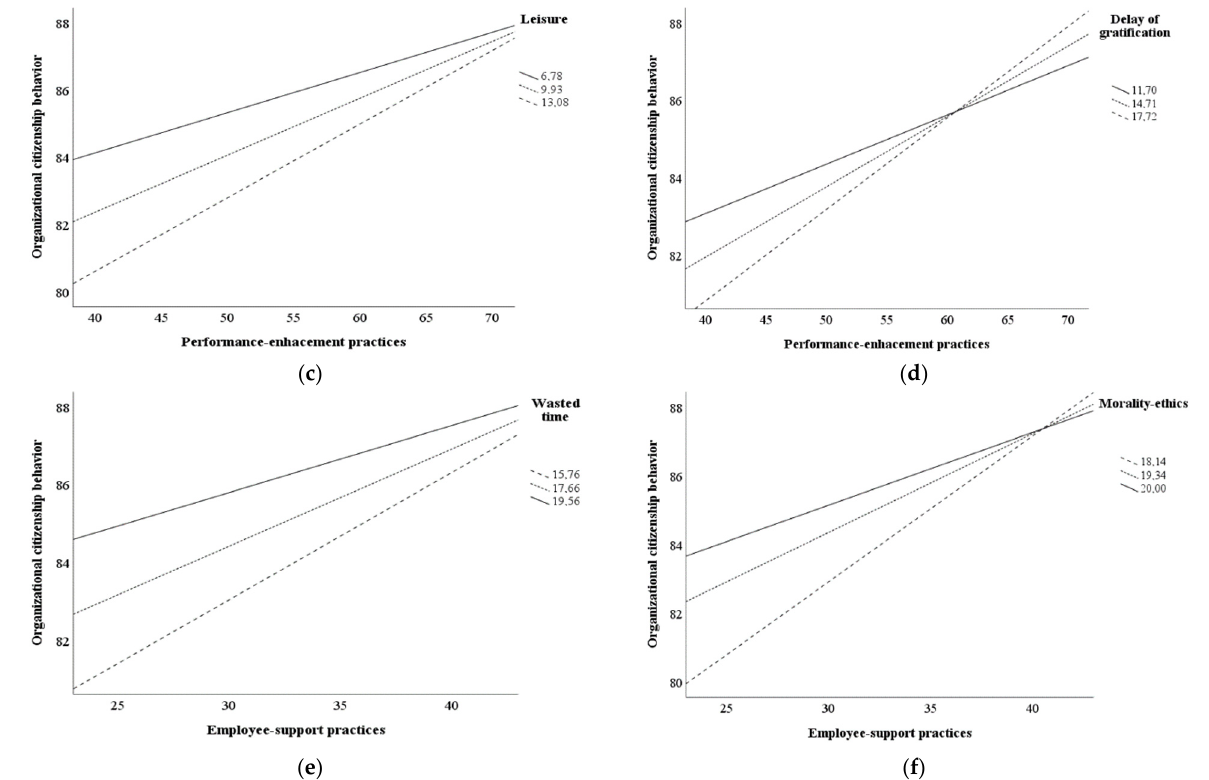
Figure 2. HRP-PWE moderations to predict Organizational Citizenship Behavior. Note. Six interaction diagrams are shown in Figure 2. Diagram ( a ) shows the variation in the main effects of HRP-P and wasted time and the interaction of these two variables. Diagram ( b ) shows variation in the main effects of HRP-P and morality–ethics and variation in the interaction of these two variables. In ( c ) it can be seen that the variation occurs only in the main effect of leisure and in the interaction of this variable with HRP-P. In ( d ) it can be observed that there is variation in the main effect of delay of gratification and the interaction of this variable with HRP-P. ( e ) shows variations in the main effects of wasted time and HRP-S and the interaction of these two variables. Finally, ( f ) shows variations in the main effects of morality and ethics and HRP-S and the interaction of these two variables.